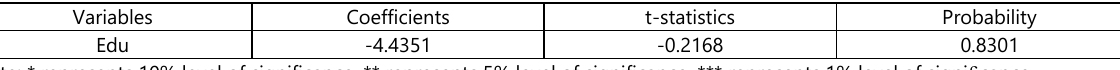
Table 4: Long-Term ARDL Model Estimates (Source: Author’s calculations)